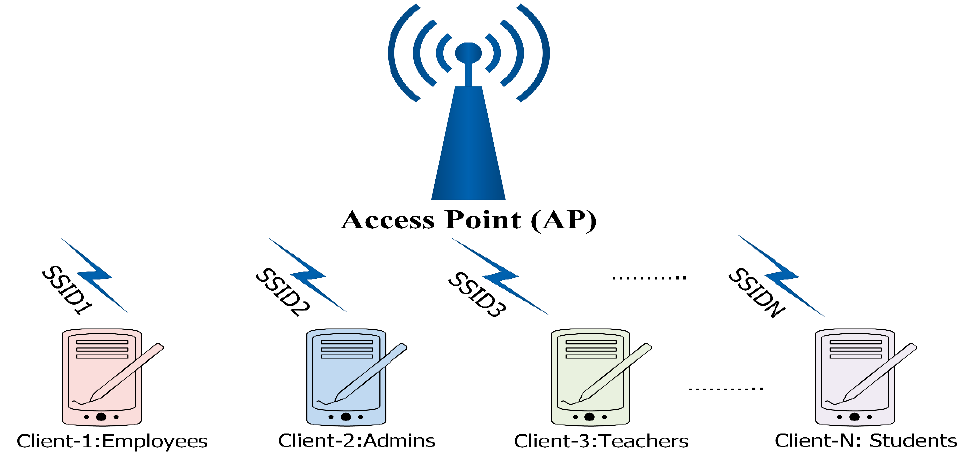
Figure 2. Multiple Services Set Identifiers (MSSIDs) technique.